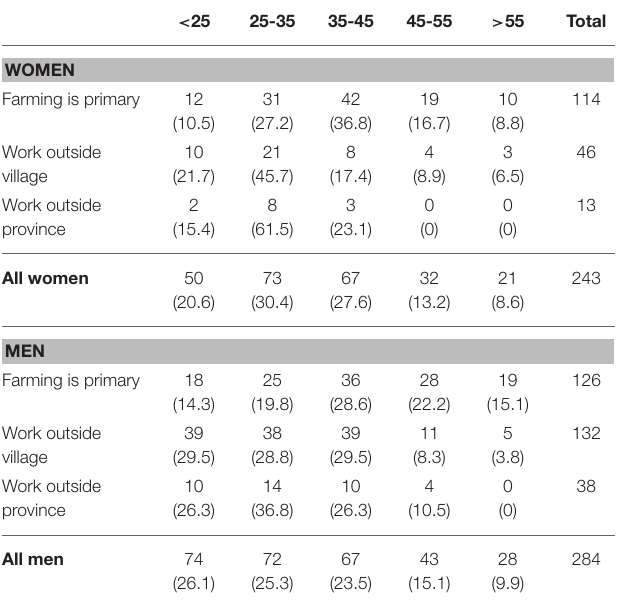
TABLE 3 | Livelihood activities by age and